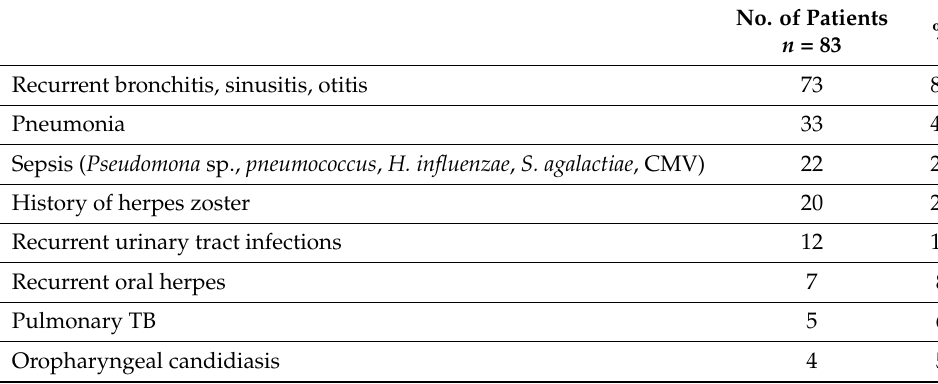
No. of Patients % n = 83